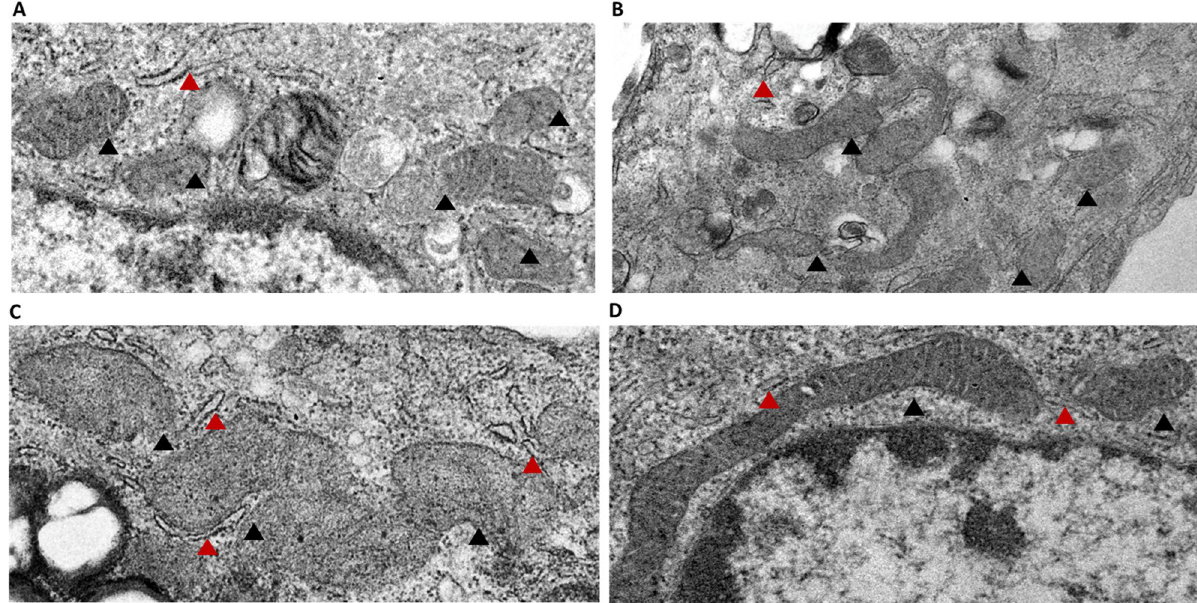
Figure 6. Transmission electron microscopy showing the effect of ( A ) Vehicle and MOTS-c treatment ( B ) 25 μM MOTS-c ( C ) 50 μM MOTS-c and ( D ) 100 μM MOTS-c on mitochondrial morphology. The U-2 OS cells were grown in Dulbecco’s modified Eagle’s medium (DMEM) supplemented with 10% fetal bovine serum (FBS) plus 1% pen-strep were treated with vehicle (Nuclease-Free Water) or MOTS-c (25, 50 or 100 μM) for 48 h and electron microscopy analysis was performed as described in methodology. The black triangles point towards the mitochondria while the red triangles point towards endoplasmic